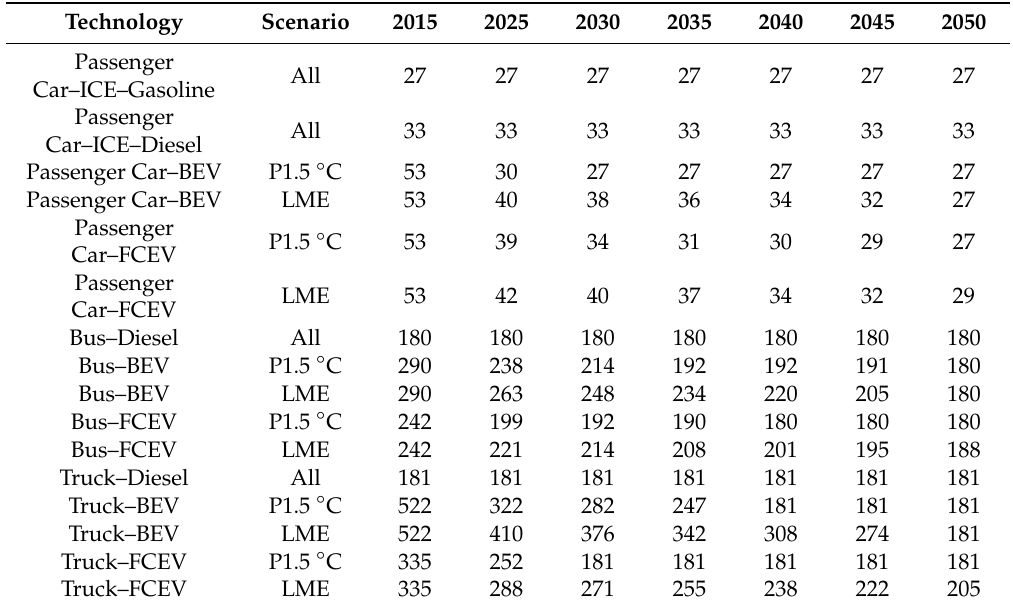
Table A14. Internal combustion and electric vehicle cost assumptions (all costs are in 1000 US $2018). Data based on Reference [35].